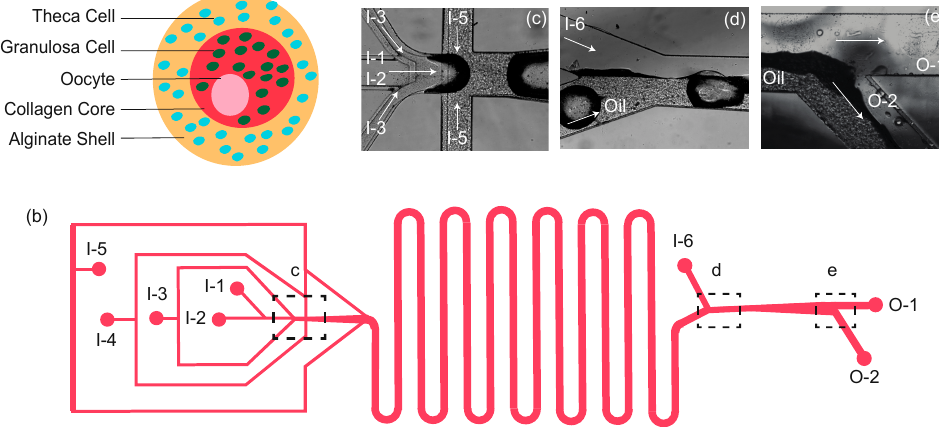
Figure 1. Design of capsule and device. ( a ) A schematic illustration of 3D ovarian follicles. The capsule incorporates murine granulosa cells within a soft collagen core surrounded by a separate layer of murine theca cells suspended in a stiffer alginate shell. ( b ) A schematic view of the microchannel system. Capsules are created at the nozzle where the solutions convene (dotted box, c). Once capsules are generated, they travel through the serpentine channels to allow additional time for gelation and are collected in the top reservoir (O-1). ( c ) A typical image of the boxed region in panel b showing the flow-focusing areas. ( d ) A typical image of the boxed region in panel b showing the entrance of the extraction channel. ( e ) A typical image of the boxed region in panel b showing the exit of the extraction channel. I-1, I-2, I-3, I-4, I-5, and I-6 are the inlets of oocyte, core, shell, Ca-mineral oil emulsion, dispatching, and extraction flows, respectively. O-1 and O-2 are outlets for the aqueous (containing capsules) and oil emulsion flows, respectively.